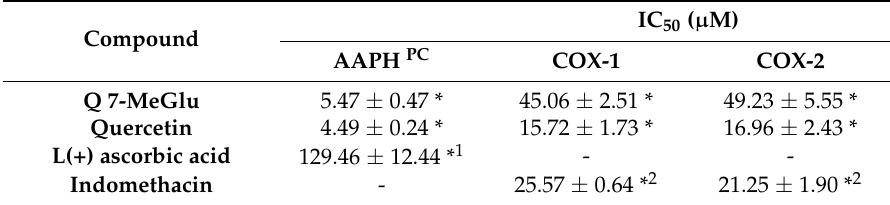
Table 3. Compilation of IC 50 in the process of inhibition of AAPH induced oxidation of phosphatidylcholine liposomes and inhibition of COX-1 and COX-2 enzyme activity by quercetin 7- O - β - D -(4”- O -methyl) glucopyranoside (Q 7-MeGlu) and quercetin. Means labeled with an asterisk (*) are significant ( p < 0.05) in the same